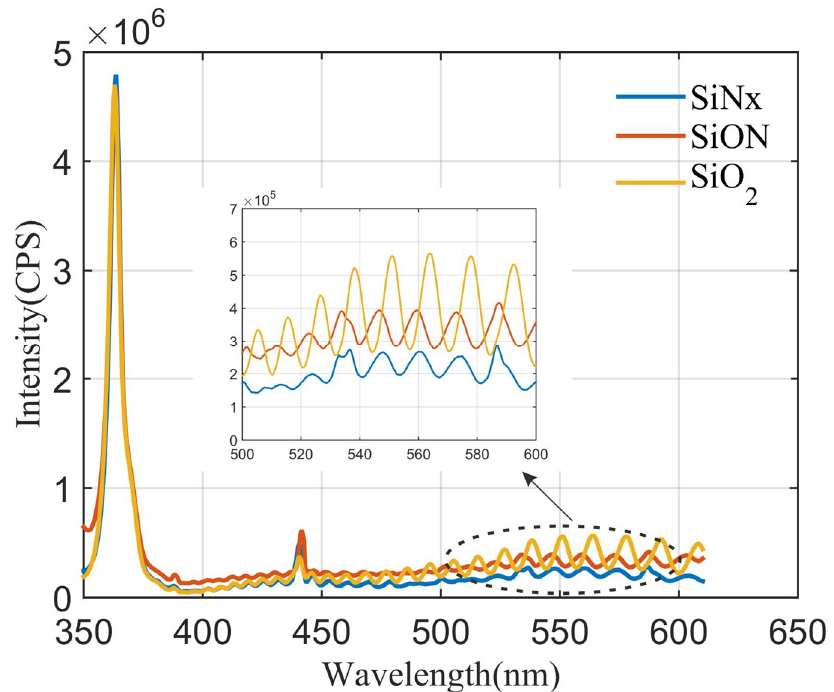
Figure 7. Photoluminescence (PL) spectra at room temperature of three samples.